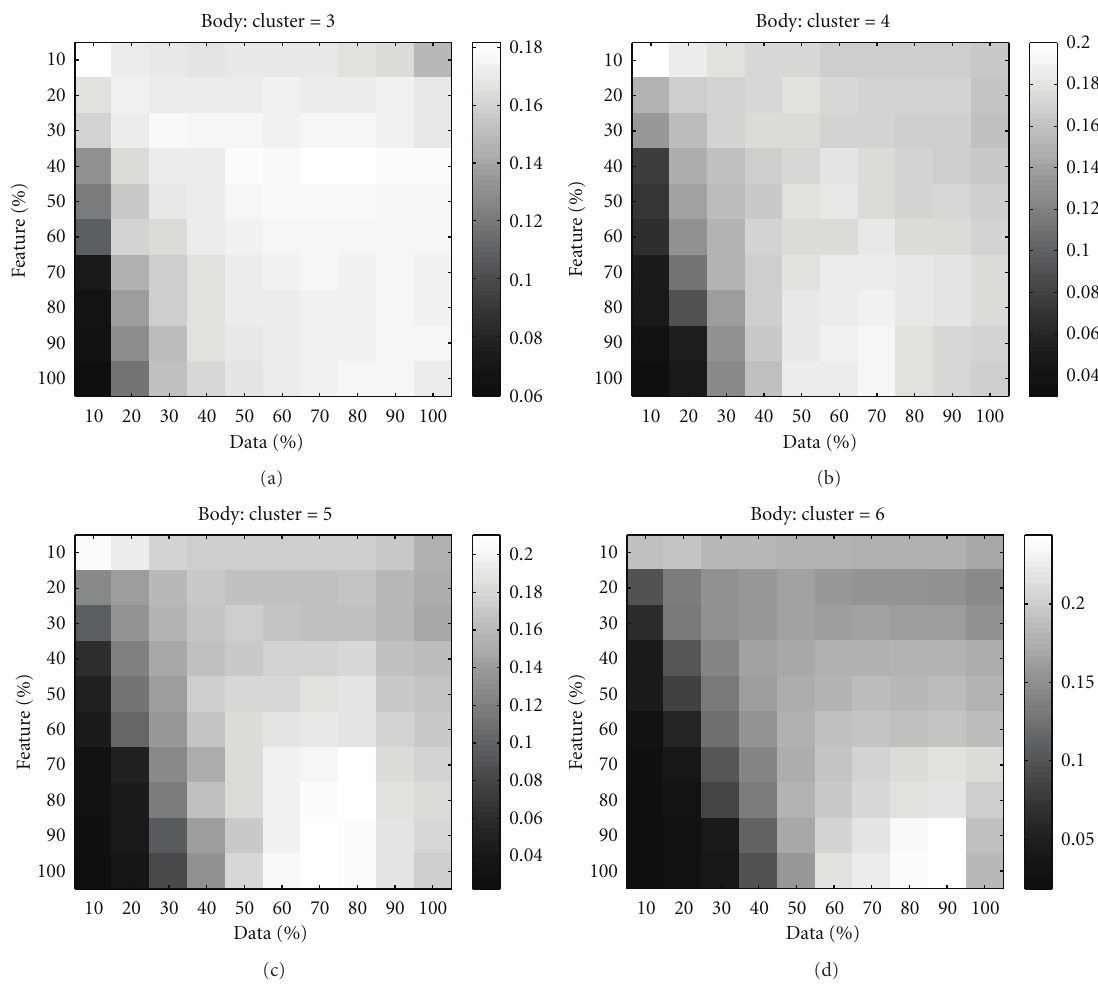
Figure 7: Heat map for Body fat data for varying in-between 3 to